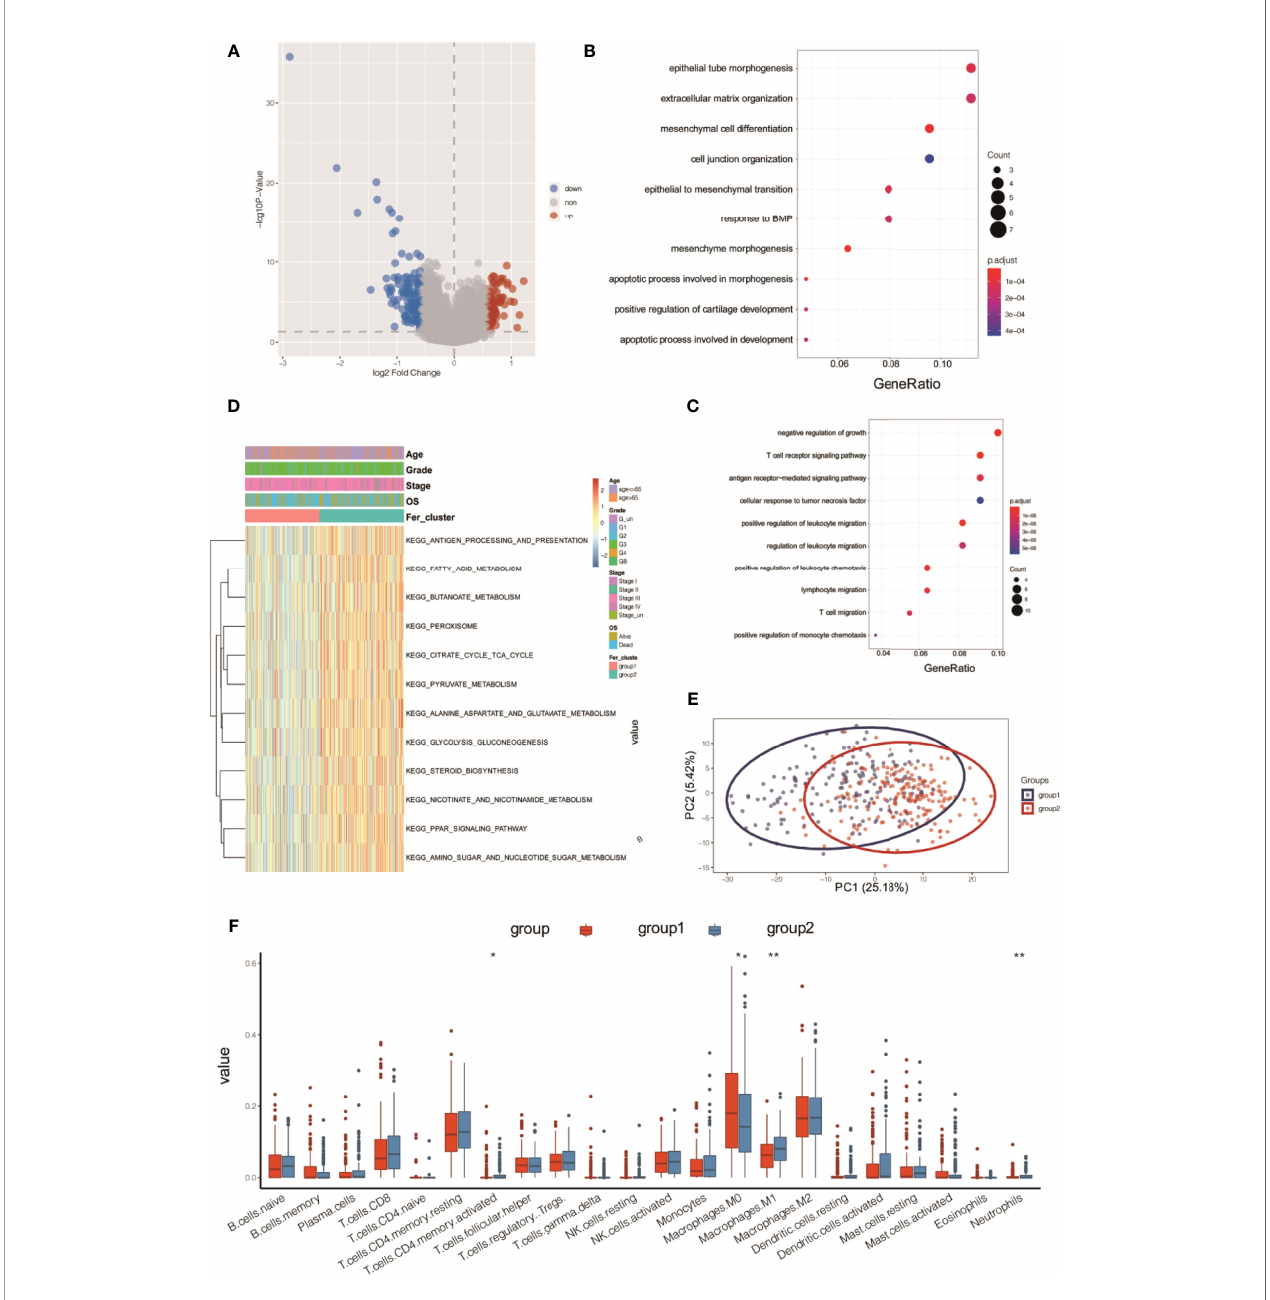
FIGURE 6 | Functional annotation analysis of differentially expressed genes beween two ferroptosis subtypes in OC tumors. (A) Volcano map of differentially expressed genes between two subtypes; (B) bubble chart of high-expression genes in Fer-1; (C) bubble chart of high-expression genes in Fer-2; (D) KEGG analysis; (E) PCA analysis; (F) tumor ICI values of the two groups. *P < 0.05, **P <